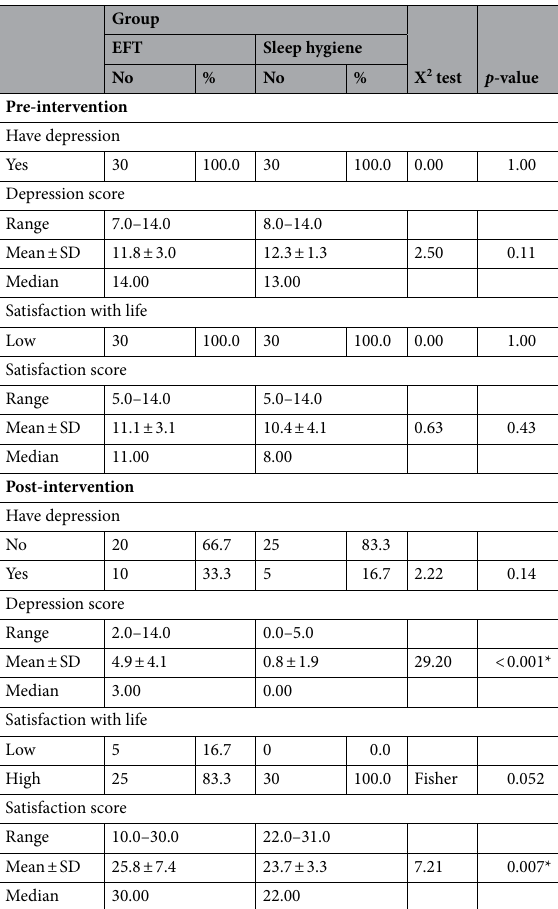
Table 3. Life satisfaction, and sleep quality among elderly patients in the two study groups throughout the intervention. (*)Statistically significant at p <